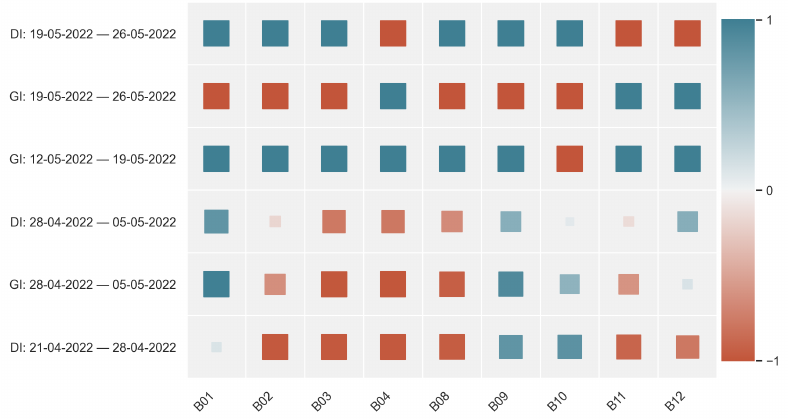
Figure 9. Example of 7-day window correlations.